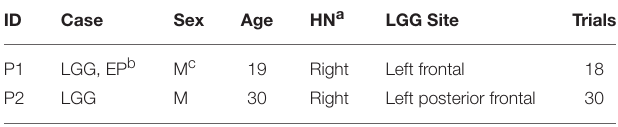
TABLE 1 | Summary of subjects and experiments.